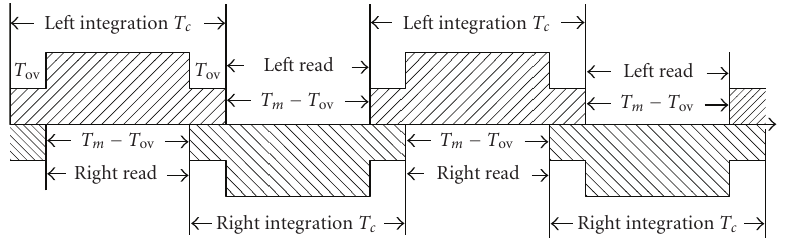
Figure 15: Illustration of the overlapping windowing in the